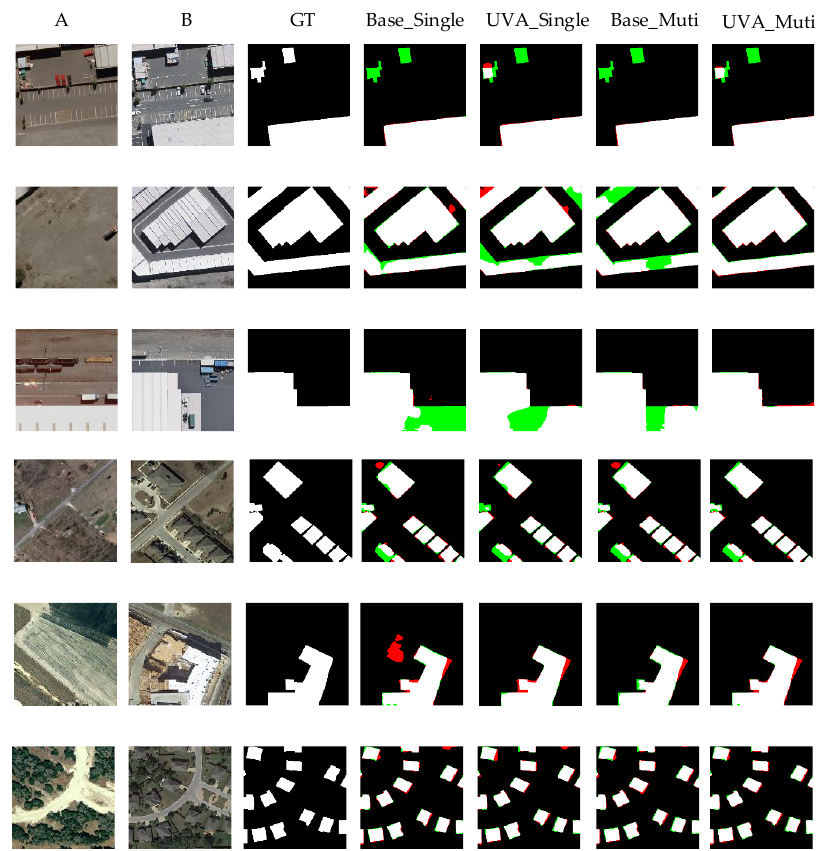
Figure 10 . Visualization for the transformer on the network structure. Figure 10. Visualization for the transformer on the network